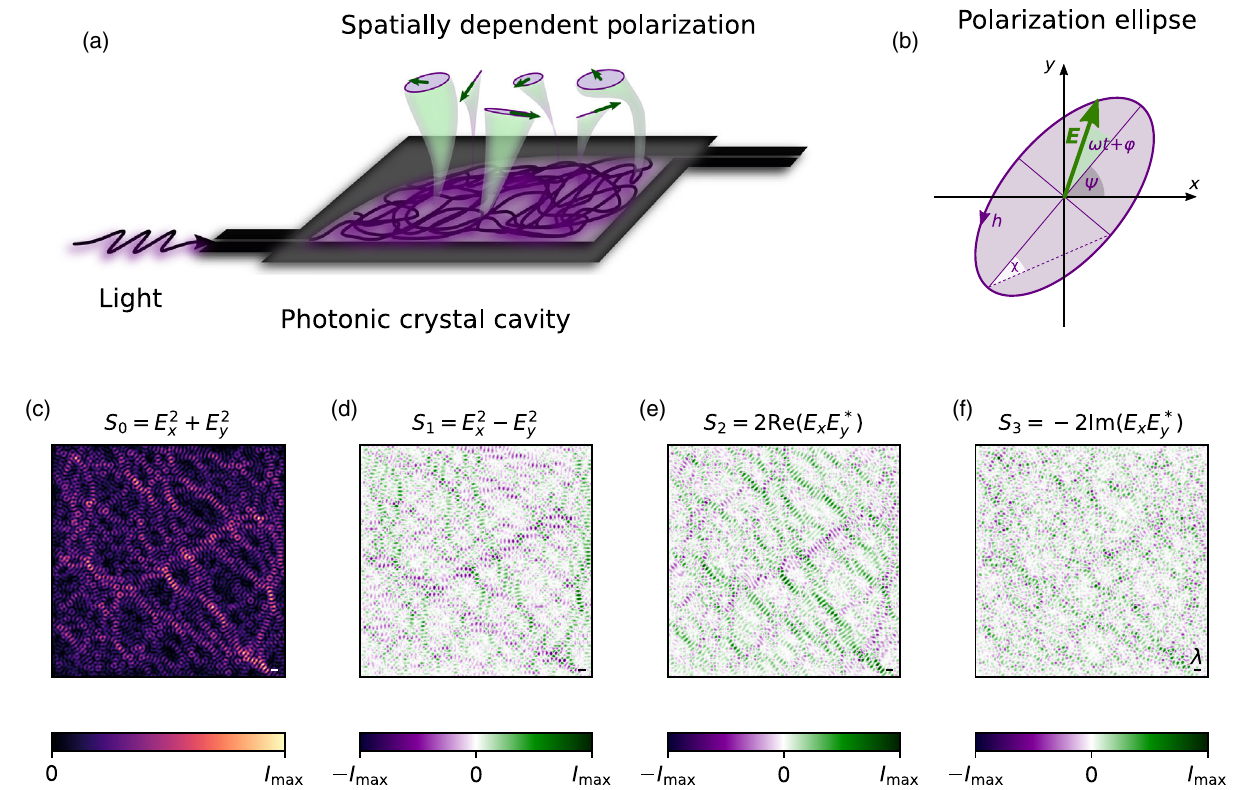
FIG. 1. Overview of the near-field measurements of light ’ s polarization in a chaotic cavity. (a) Schematic of the experimental realization of random light waves in the planar photonic crystal cavity (black). Inside the cavity, light exhibits a spatially dependent polarization. This is illustrated by a few different polarization ellipses (purple ellipses) observed at different points in the cavity (indicated by the green shadows). (b) Parametrization of the polarization ellipse, describing the local polarization state of light. (c) – (f) Near-field maps of the Stokes parameters of the optical random field in a square region of 17 μ m × 17 μ m inside the chaotic cavity. Note þ E 2 that S 0 ¼ E 2 is the total intensity of the vector field. This is displayed with a false-color map ranging from 0 to I x y the maximum measured intensity. Here, S ( i ¼ 1 , 2, 3) describes the polarization state of light, with respect to linear (horizontal- i vertical), linear ( (cid:2) 45 deg), and circular (right-left) polarizations, respectively. These Stokes parameters are also represented with false- color maps, which this time range from − I to I max max